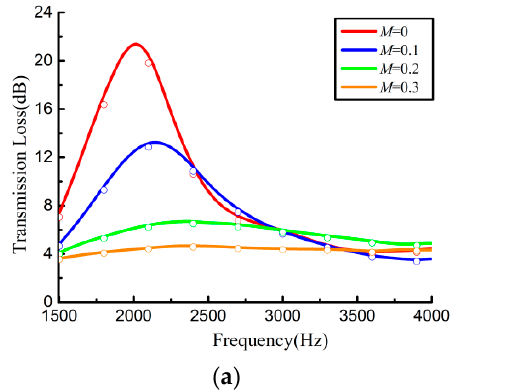
Figure 19. The ADCAA system. In order to adapt the planar BAU to the cylindrical surface, the perforated plate and the cavities in the planar BAU were bent along the circumference of the duct, while the volume of each cavity was kept unchanged, as shown in Figure 20. The bent BAU struc- ture constitutes the basic acoustic absorption unit of the cylindrical non-uniform acoustic absorber. In Figure 20, the inner radius